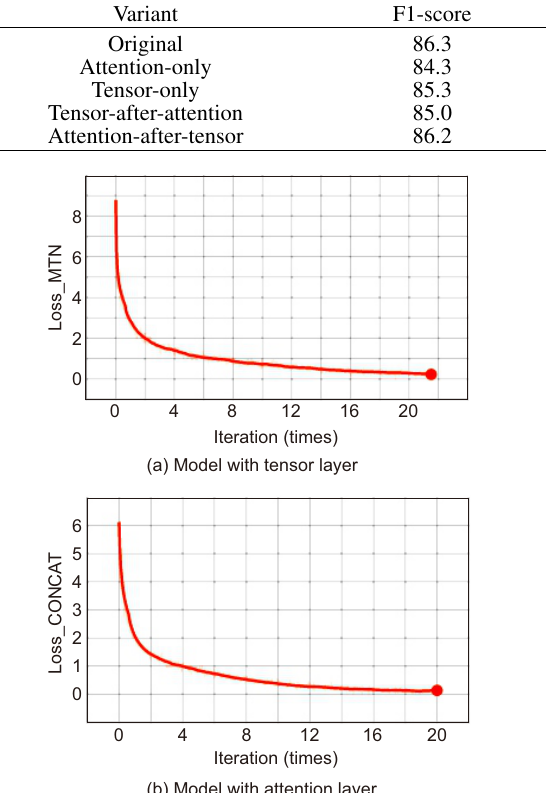
Fig. 7 Loss variances of tensor and